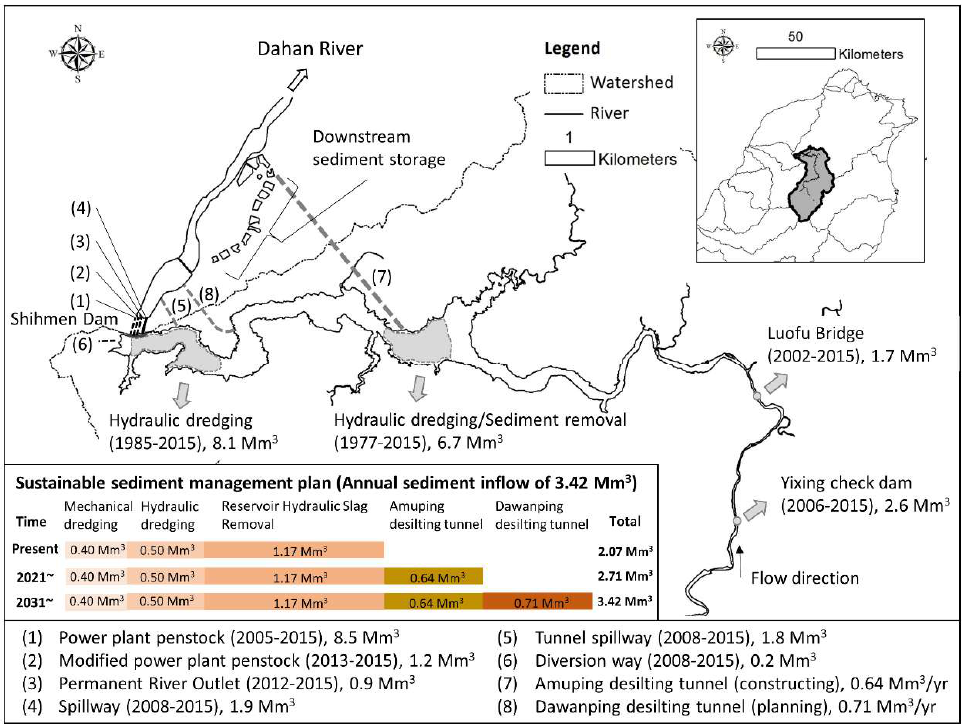
Figure 3. A diagrammatic map showing management strategies of Shihmen Reservoir. For each strategy, the years conducted are provided in parentheses, followed by the cumulative volume of sediment removed during implementation of that strategy, in Mm 3 . Data are from WRA [26–29].